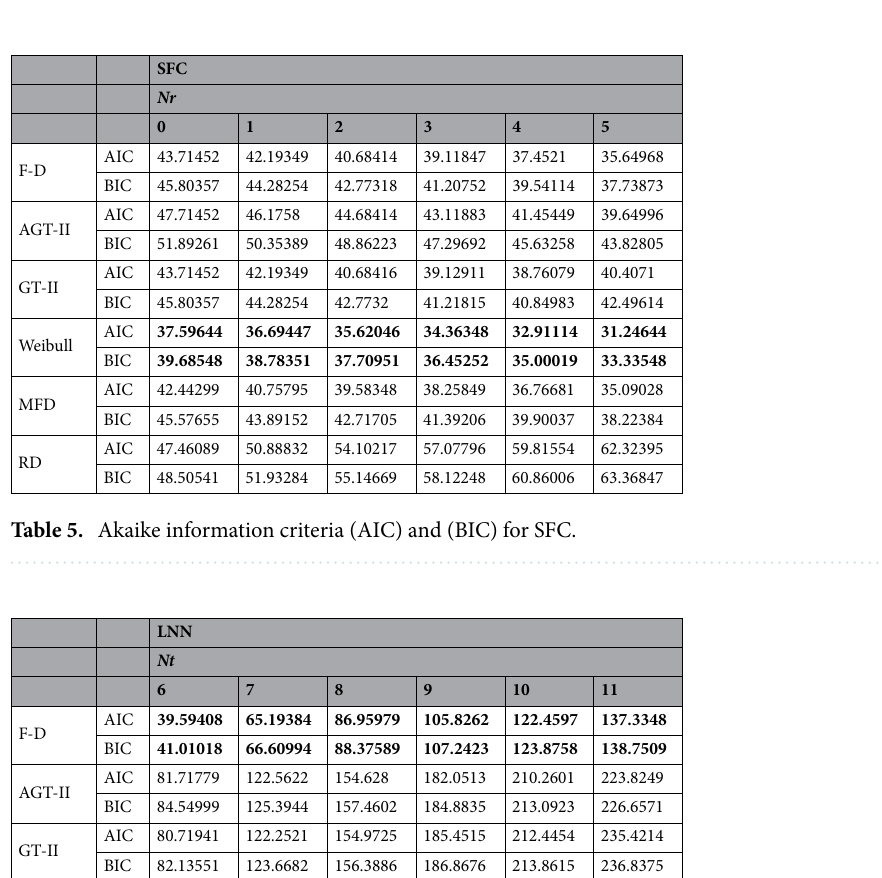
Table 4. Estimates of the parameters of statistical distribution for LDMM.